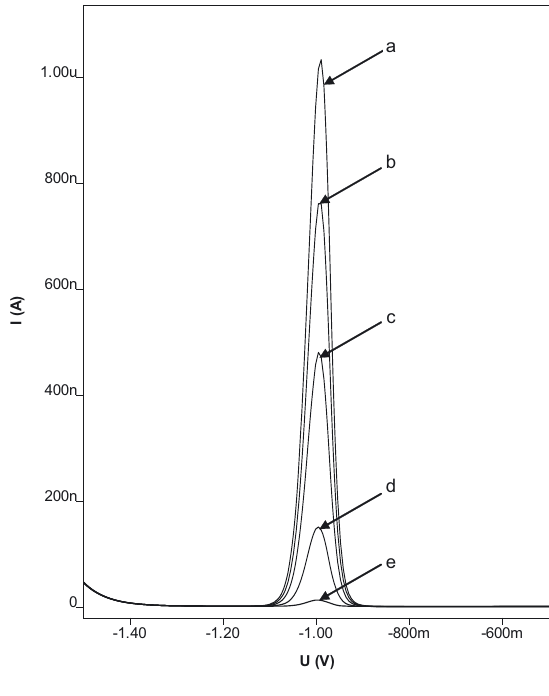
Figure 1. Differential pulse anodic stripping voltammograms of Zn (II), [Zn] = 4.2·10 -6 M, with progressive addition of EDTA. [EDTA] (M): 0 (a) , 1.2·10 -6 (b) , 2.5·10 -6 (c) , 3.7·10 -6 (d) , 4.2·10 -6 (e) . Supporting electrolyte: 0.2 M NaClO M pH 5.4 sodium acetate buffer; deposition potential: -1.200 V; deposition time: 90 s; sweep rate: 10 mV s -1 .